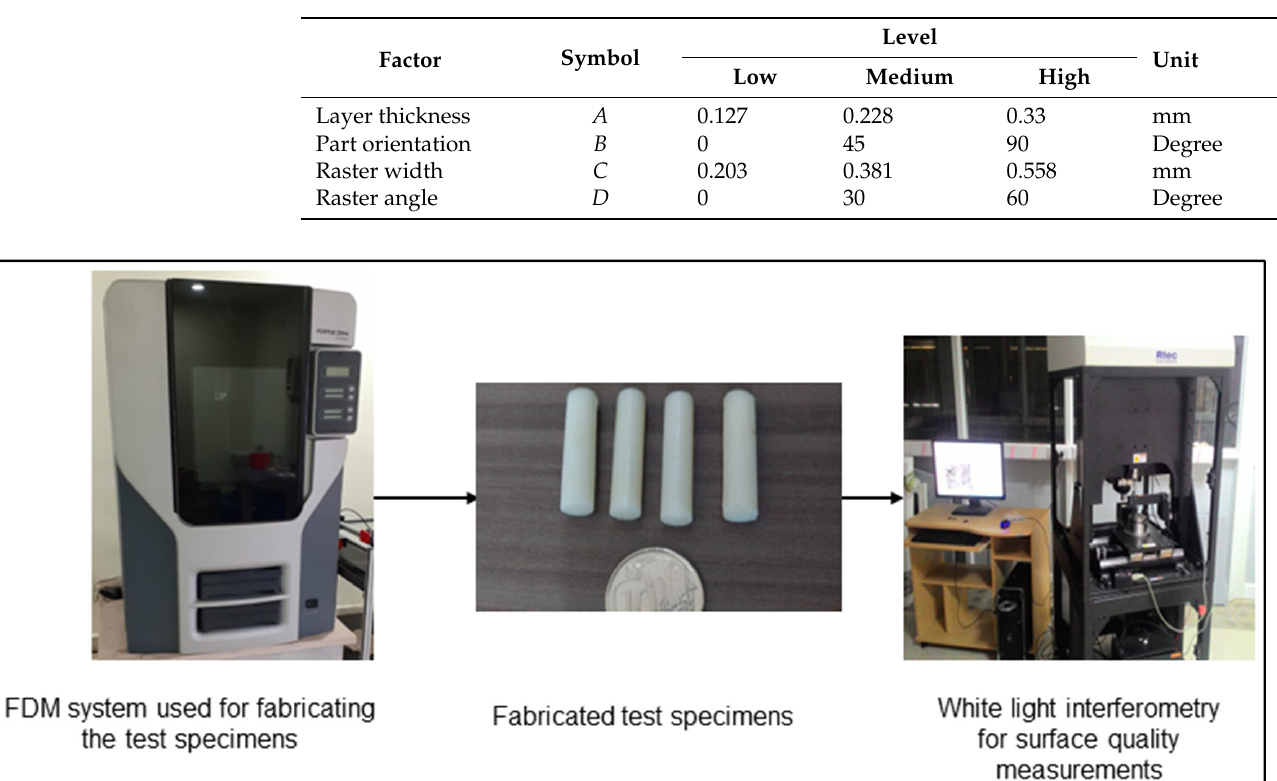
Table 1. FDM process parameters and levels.